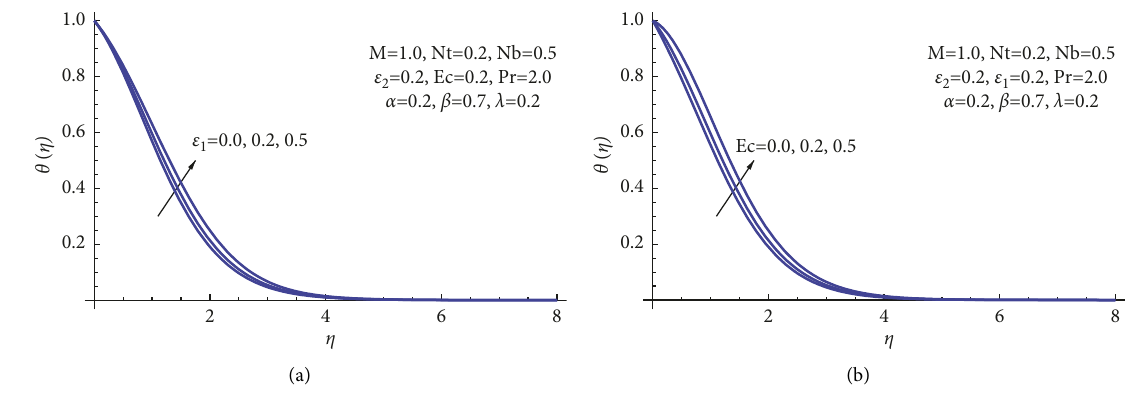
Figure 6: (a) Impact of ε